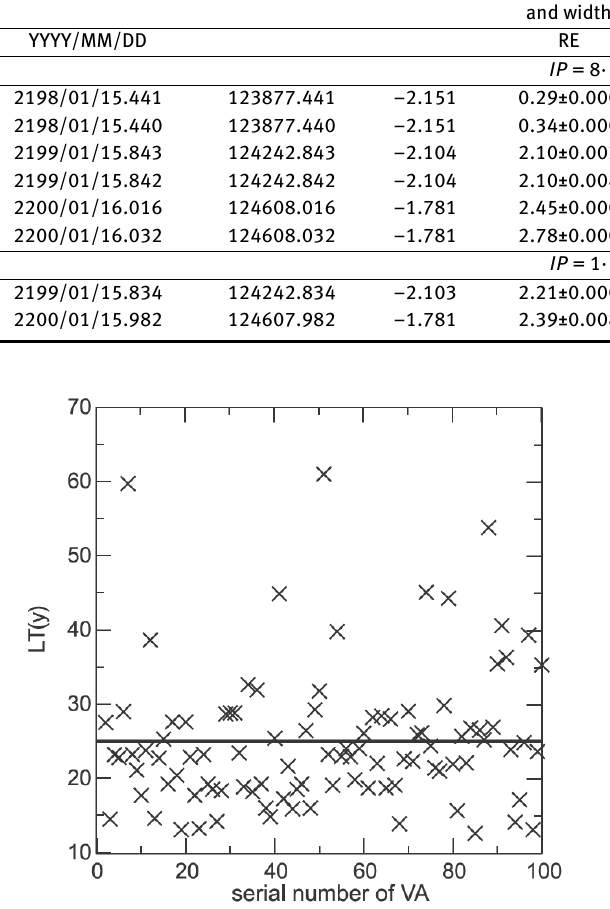
Figure 2. Lyapunov time of 101 VAs of the asteroid 2001 BB16. Hori- zontal line denotes mean